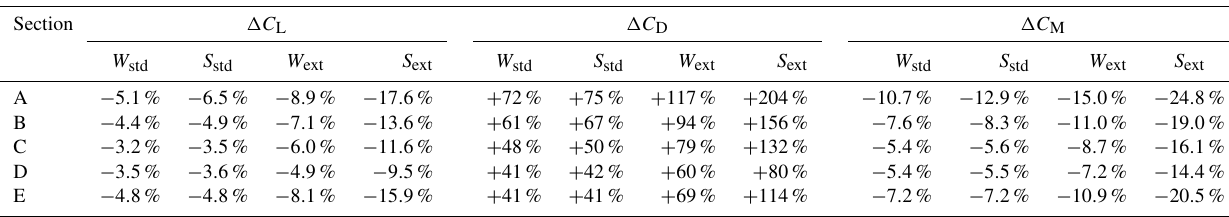
Table 6. Aerodynamic penalties on Sections A–E at α = 4 ◦ .